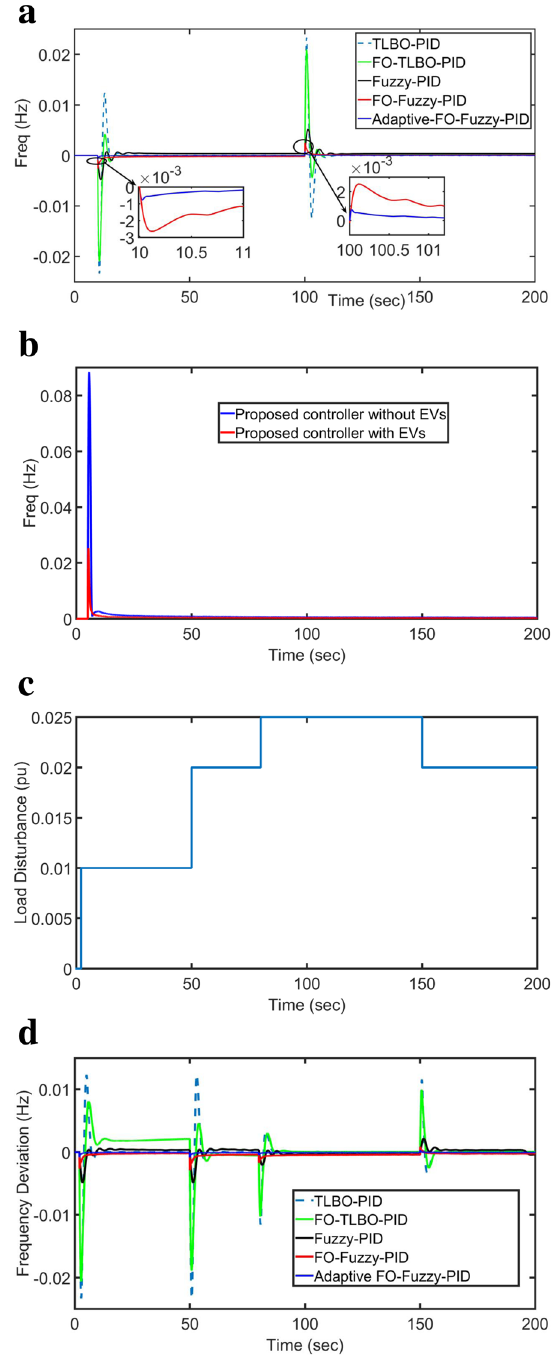
Fig. 9 a Case 1- Frequency deviation response, b Case 2 - Frequency deviation response, c Case - 3 Multistep Load deviations, d Case 3 - Frequency deviation